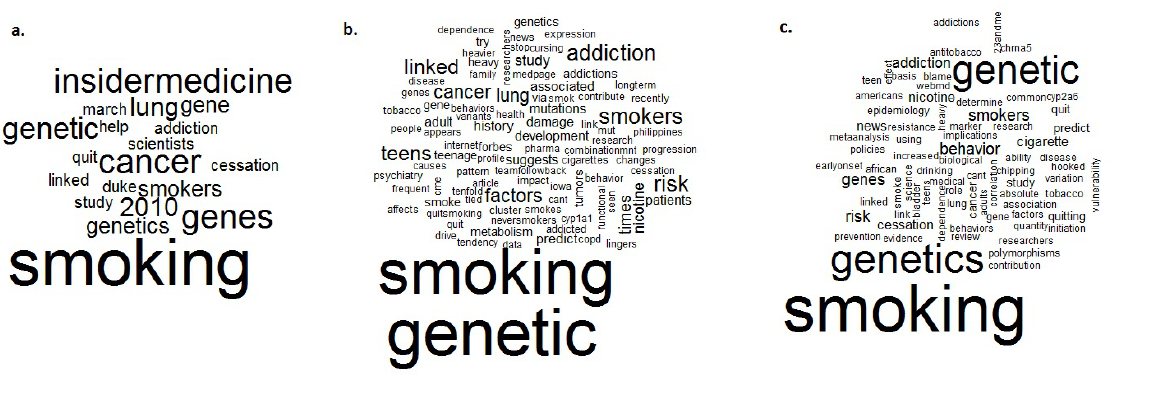
Figure 3. Word clouds presenting the most used words on YouTube, Twitter, and Google. (a) word cloud including the most used words in the title of YouTube posts; (b) the most used words from the posts in Twitter; (c) the most used words in Google. Each word’s frequency is correlated with font